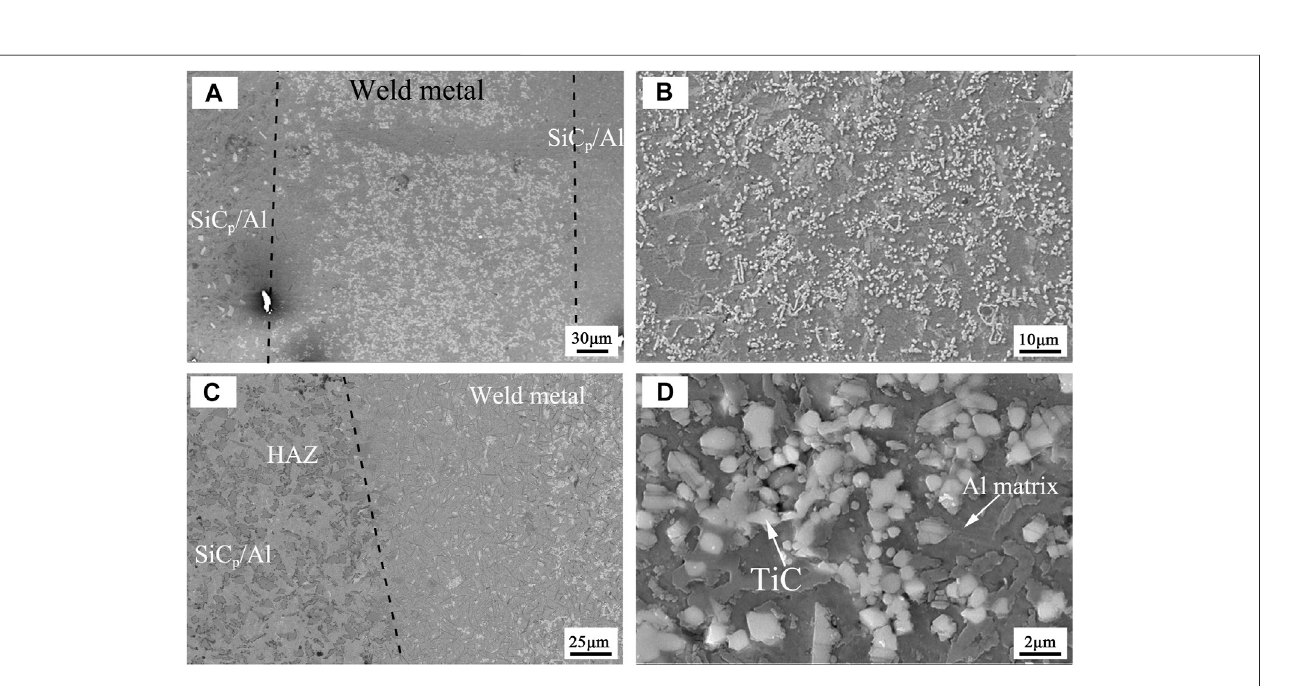
Frontiers in Materials |